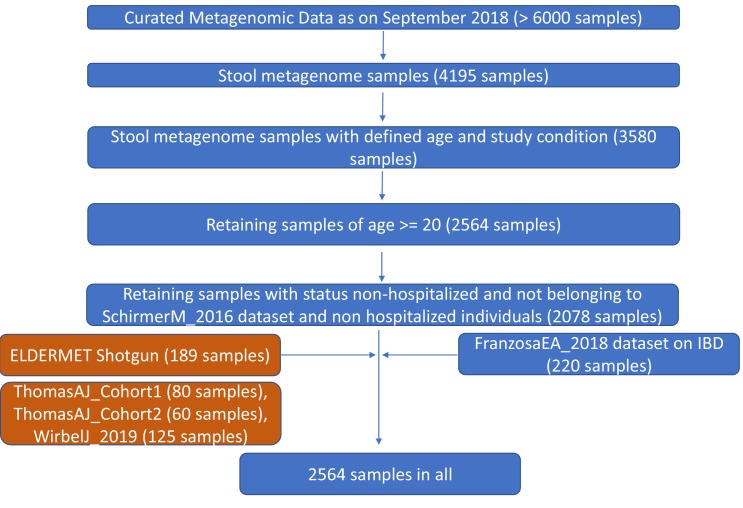
Pictorial summary describing the workflow used for preparing a core set of around 2564 gut metagenomic datasets derived from the publicly available datasets (curatedMetagenomicData9 and Franzosa et al 20188) and the ELDERMET repository.While the datasets used in the core-analysis are highlighted in blue, the validation cohorts including the ELDERMET are highlighted in brown.